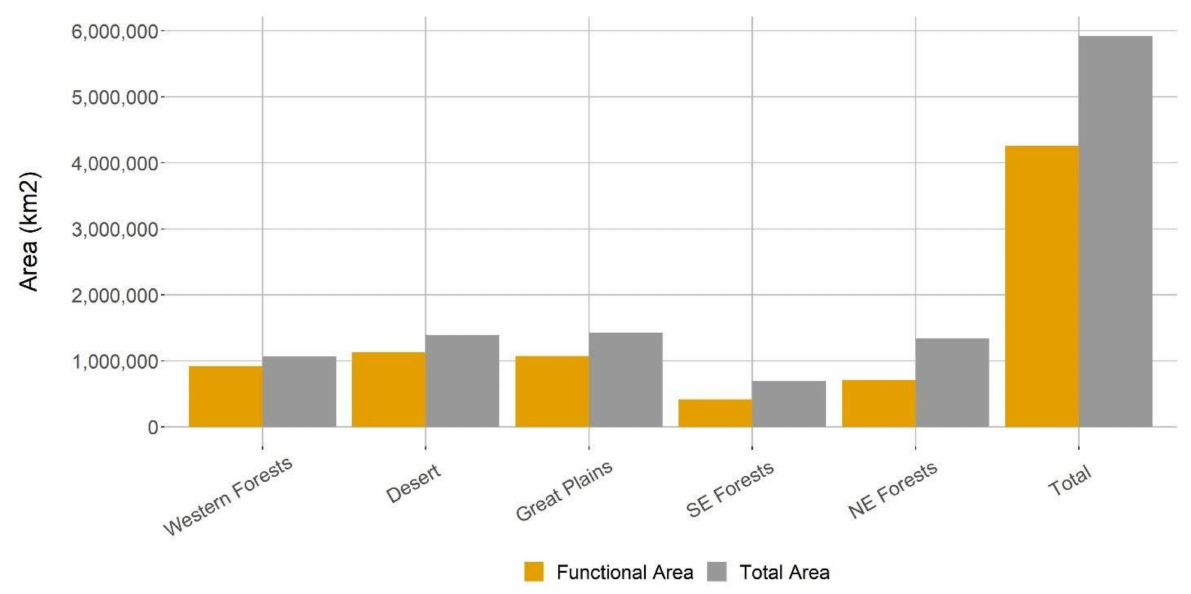
Figure 7. Total area of natural and semi-natural lands compared to functional area. The leftmost column depicts the total amount of area in the conterminous US that is not classified by the NLCD map as urban/built-up or high-intensity row crops (i.e., total land area that is natural or semi-natural land cover) or water bodies. The leftmost orange column depicts the total functional area of these same land cover types. The other pairs of columns depict the area and functional area for each ecoregion (see Figure 3)